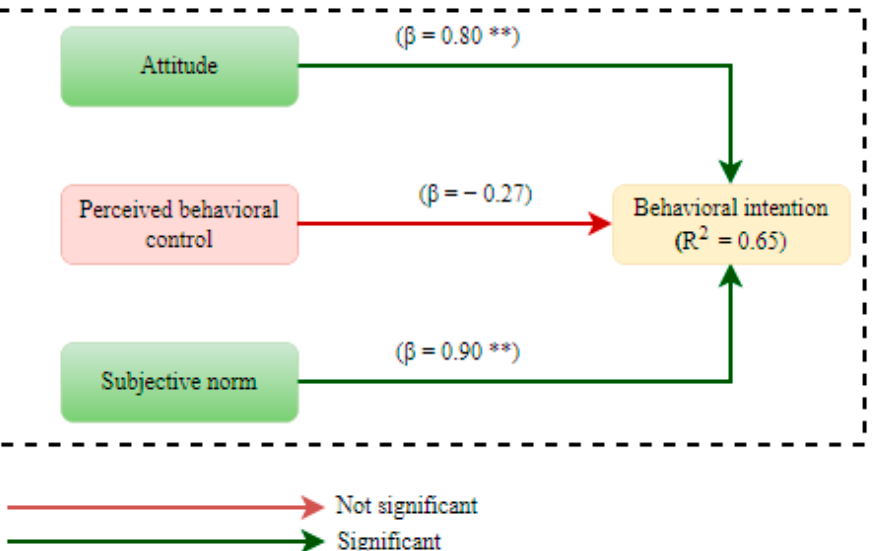
Figure 5. Predicting Behavioral intention based on the Theory of Planned Behavior constructs (Model 1) . * p < 0.05, ** p < 0.001, R 2 = Nagelkerke R square.